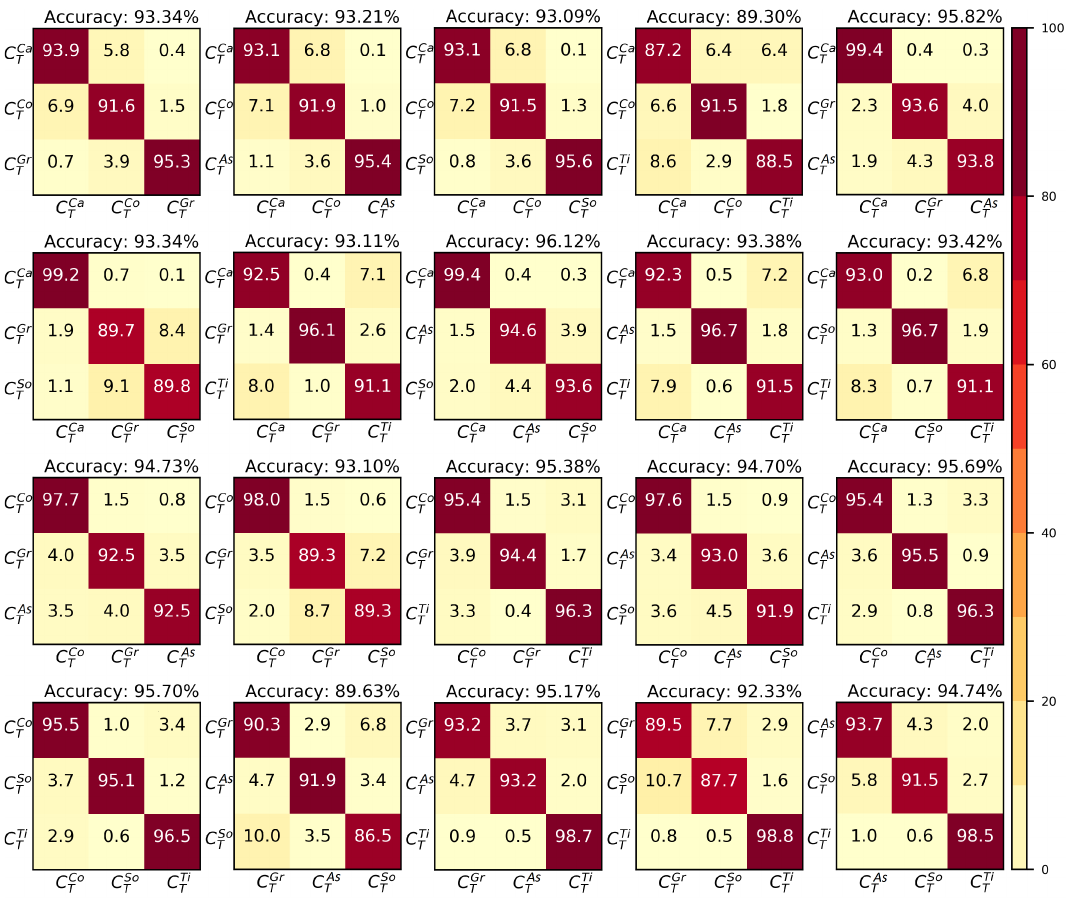
Figure A2. Confusion matrices of ternary classification with lower back sensor. All results were obtained with all features set (194 features) using SVM classifier. Classes: C Ca = grass , C As = Asphalt , C So = soil , and C Ti = tiles C Gr T T T T